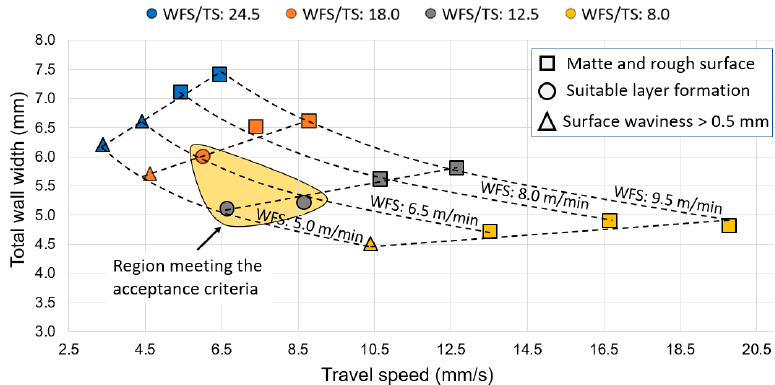
Figure 11. Experimentally based work envelope: Initial results.